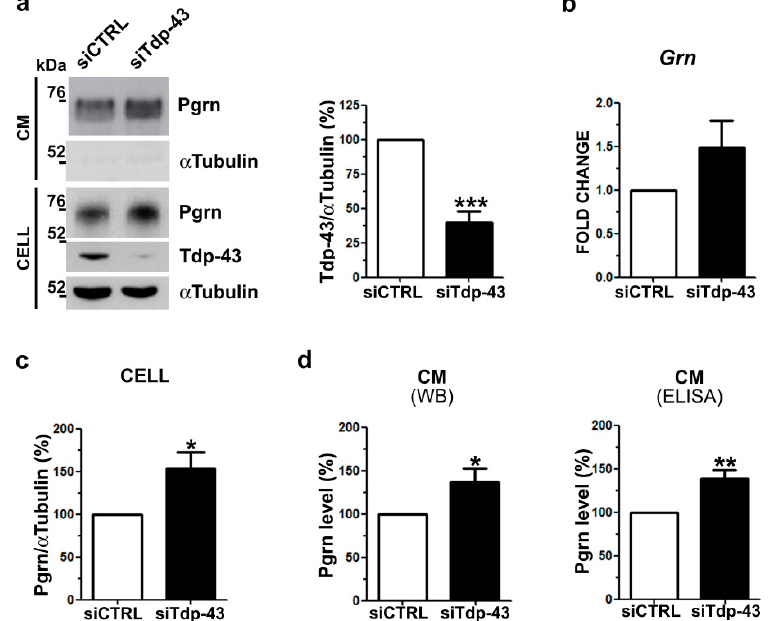
Figure 1. Progranulin (Pgrn) protein content and secretion in murine TDP-43 loss-of-function (LOF) cells. ( a ) Representative Western blot (WB) images (left panel) of Pgrn protein in cell lysates (CELL) and conditioned media (CM) upon Tdp-43 knock-down (siTdp-43) in murine motoneuronal-like NSC-34 cells compared to negative control siRNA-transfected (siCTRL) cells. Densitometric analysis (right panel) shows Tdp-43 gene silencing efficiency. α TUBULIN was used for intracellular data normalization and as a non-secreted control protein in CM (mean ± s.e.m.; n = 5 independent experiments; two-tailed unpaired t test; *** p < 0.001). ( b ) Real time PCR of Grn gene expression upon Tdp-43 depletion (mean ± s.e.m.; n = 3 independent experiments; two-tailed unpaired t test). ( c ) Densitometric and statistical analysis of intracellular (CELL) Pgrn protein content shown in ( a ) (mean ± s.e.m.; n = 5 independent experiments; two-tailed unpaired t test; * p < 0.05). ( d ) Secreted Pgrn levels detected in CM by WB shown in ( a ) and by ELISA assays (mean ± s.e.m.; n = 4 independent experiments; two-tailed unpaired t test; ** p < 0.01).